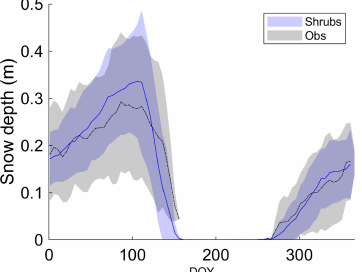
Figure 2. Mean observed and modelled 5d average snow depth av- eraged over 2004–2017 for the shrub simulation. Shaded areas show the standard deviation of the daily mean for 2004–2017.